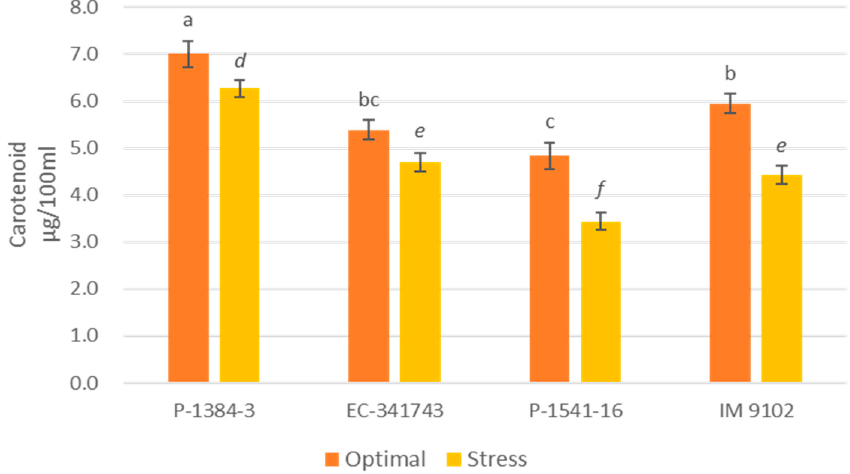
Figure 4. Carotenoid content of four field pea genotypes under optimal and heat stress. Columns with different letters indicate significant difference at p ≤ 0.05 (Fisher LSD test).